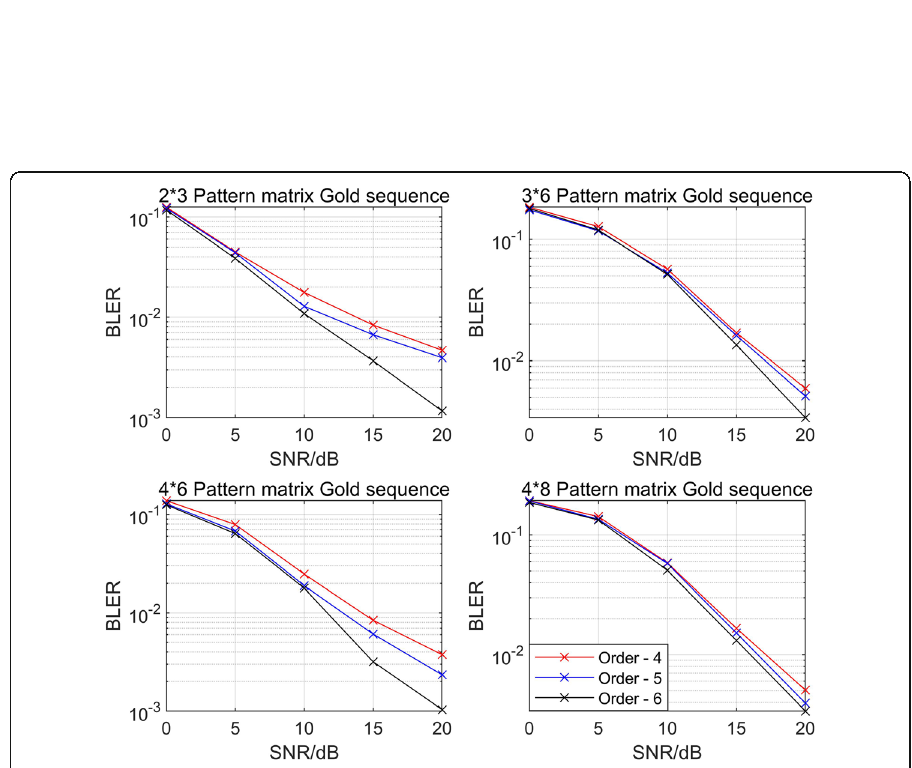
Fig. 7 Gold sequence spread spectrum based on PDMA pattern matrix with different dimensions. The spread spectrum performance comparison of Gold sequence of order 4, order 5, and order 6 under different dimensional pattern matrices. The dimension of pattern matrix is 2 (cid:5)